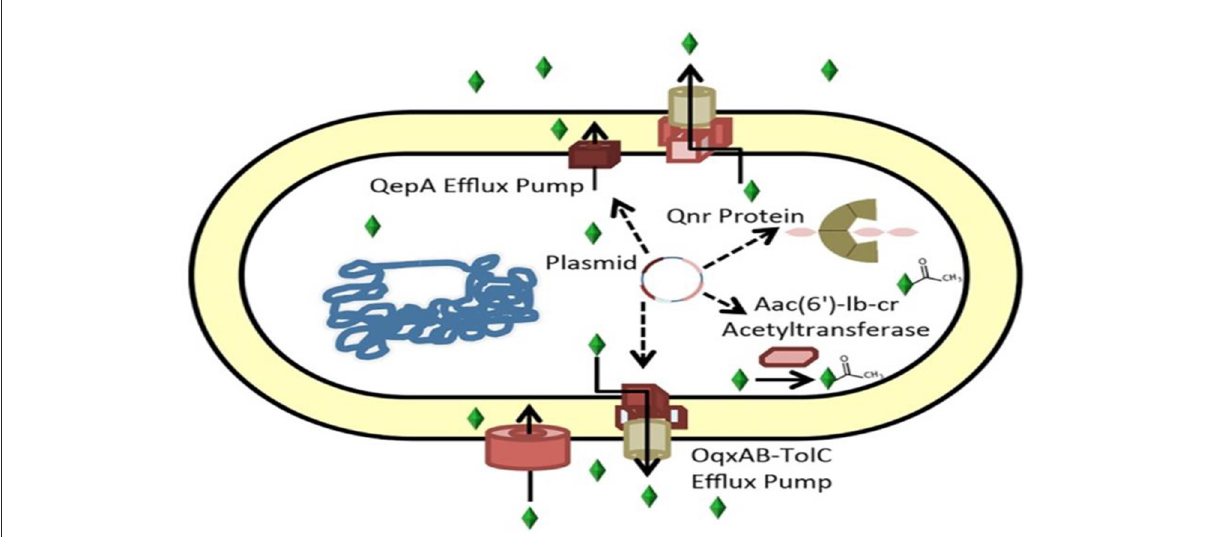
FIGURE3 Mechanisms of ciprofloxacin resistance carried by plasmids (82). Genes encoding the ciprofloxacin efflux pumps can be found in plasmids. Aac(6’)-Ib-cr, an aminoglycoside-modifying acetyltransferase that acetylates and inactivates ciprofloxacin, or QepA or OqxAB, the Qnr protein, which binds